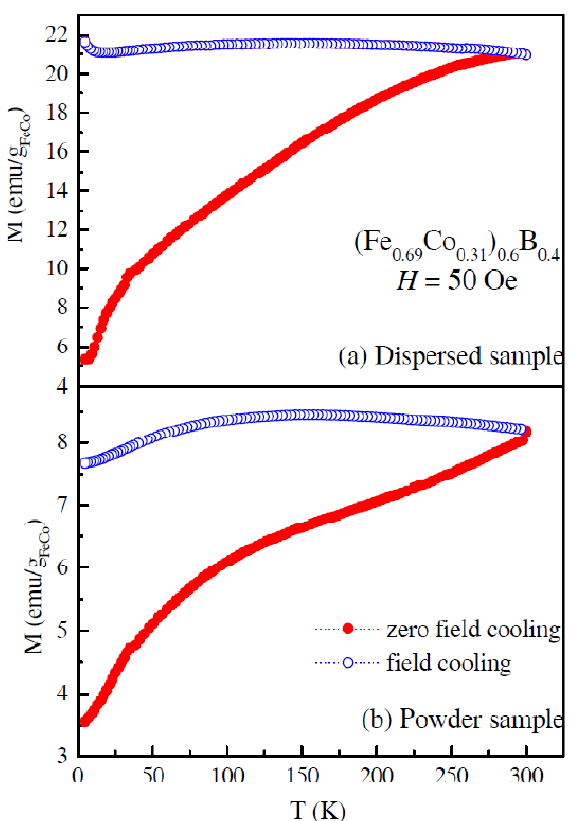
Figure 2. Magnetization vs. temperature curves for (Fe powder ( b ) particles measured under zero-field-cooling (ZFC) and field-cooling (FC)